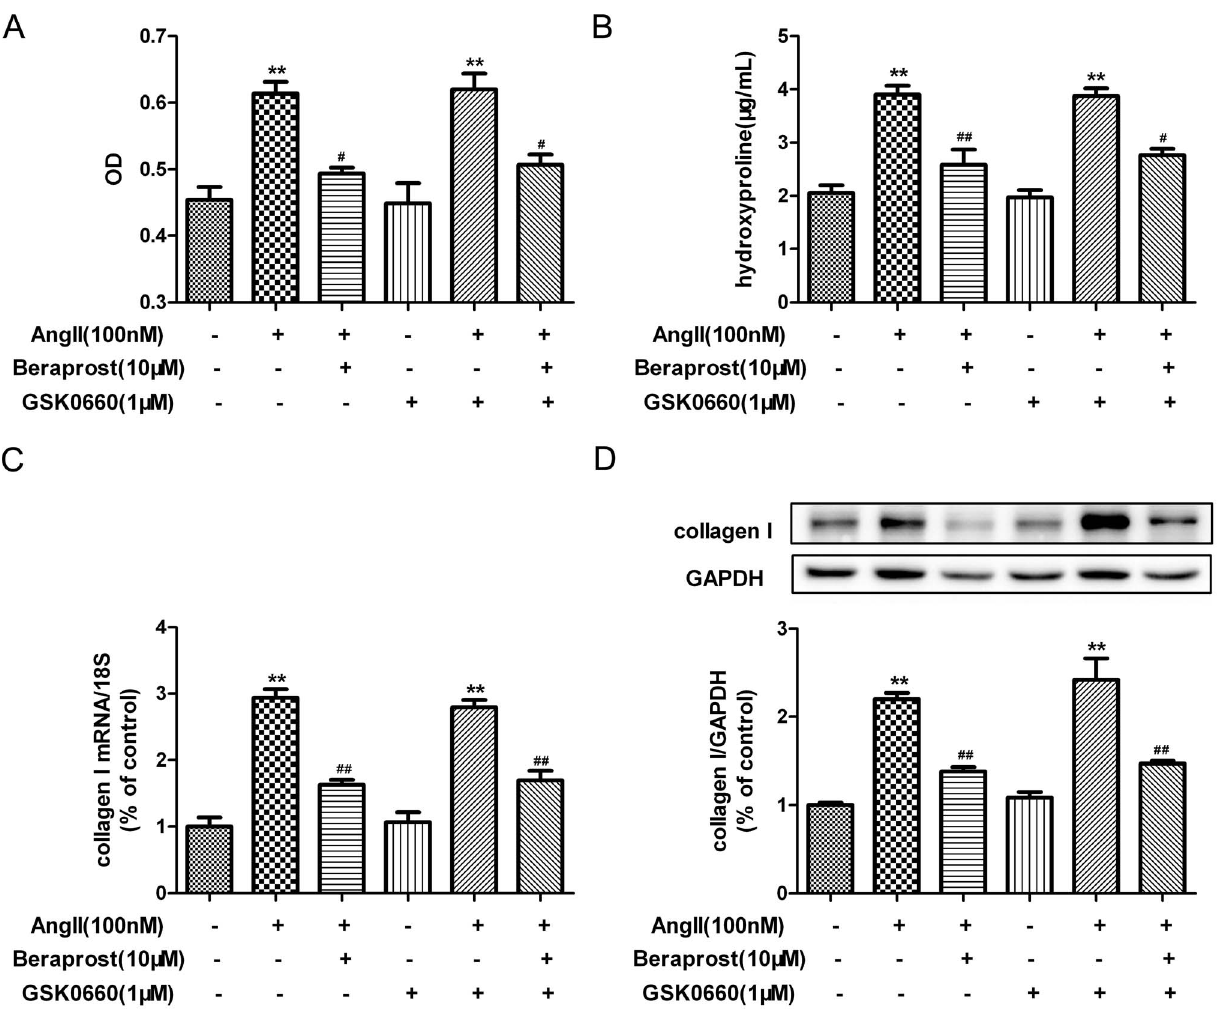
Figure 5. Peroxisome proliferators-activated receptor b / d (PPAR b / d ) is not involved in attenuating effect of beraprost on Ang II- induced cardiac fibroblast proliferation and collagen I synthesis. Neonatal rat cardiac fibroblasts were serum deprived for 24 h and pre- treated with specific PPAR b / d antagonist GSK0660 (1 m M) for 4 h. Cells were then incubated with beraprost (10 m M) for 4 h followed by Ang II (100 nM) stimulation for an additional 24 h. (A) The Nnumber of cells was represented as an OD value using a cell count assay. (B) Content of hydroxyproline in cell culture medium was determined. (C) Collagen I mRNA expression was assessed by real time PCR. (D) Cell lysates were tested for collagen I protein expression by western blot. Values are expressed as mean 6 SEM. Cells without Ang II and beraprost stimulation served as a control (con). ** P , 0.01, compared with con, # P , 0.05, ## P , 0.01 compared with Ang II stimulated group following with or without GSK0660 pre-treatment.